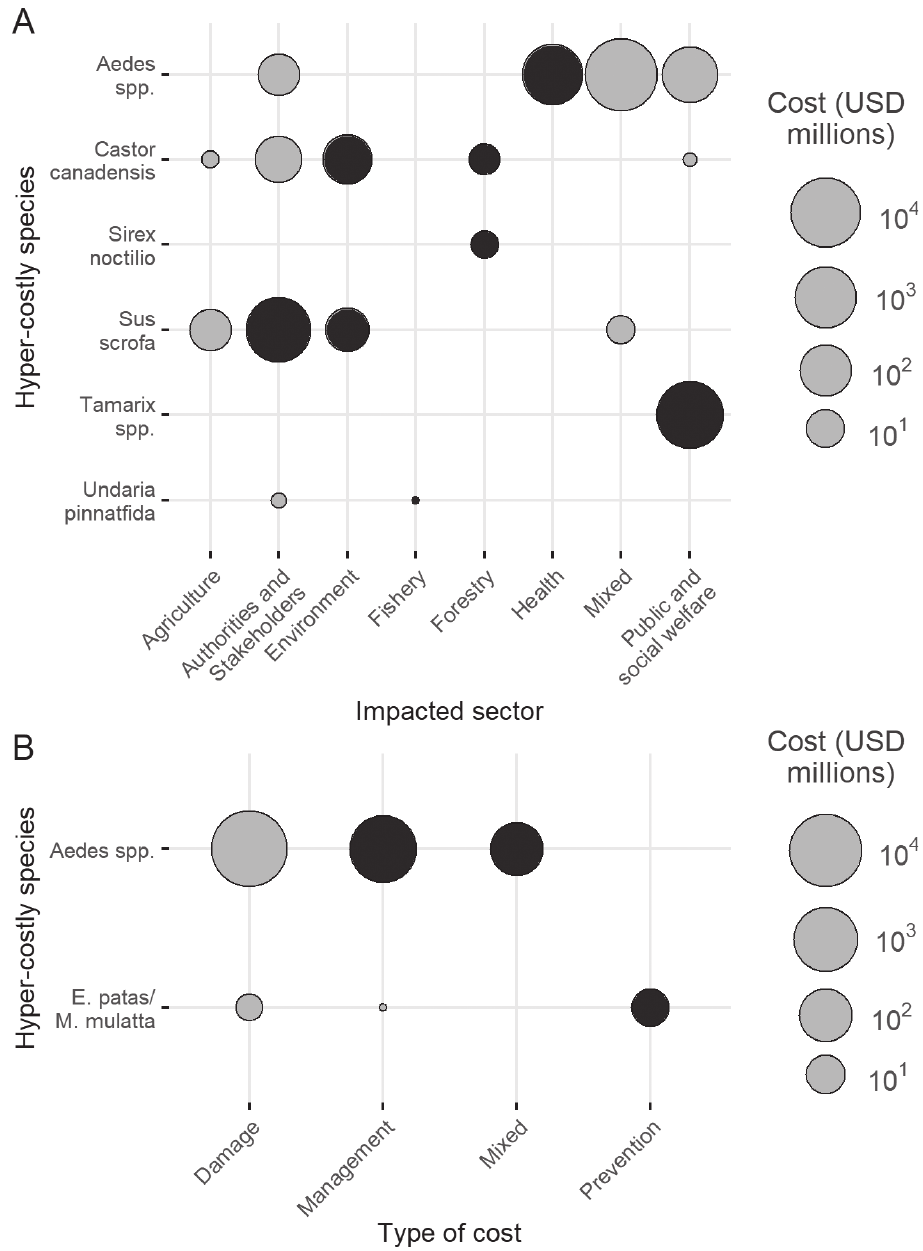
Figure 5. Costs of invasions by hyper-costly taxa A impacted sector and B type of cost. Black circles represent the hyper-costly taxa per impacted sector or type of cost and the grey circles represent the costs of each taxa in the impacted sector or type of costs where the taxa are not hyper-costly. Aedes spp. represents Aedes aegypti and Aedes albopictus ; E. patas / M. mulatta represents Erythrocebus patas and Macaca mulatta